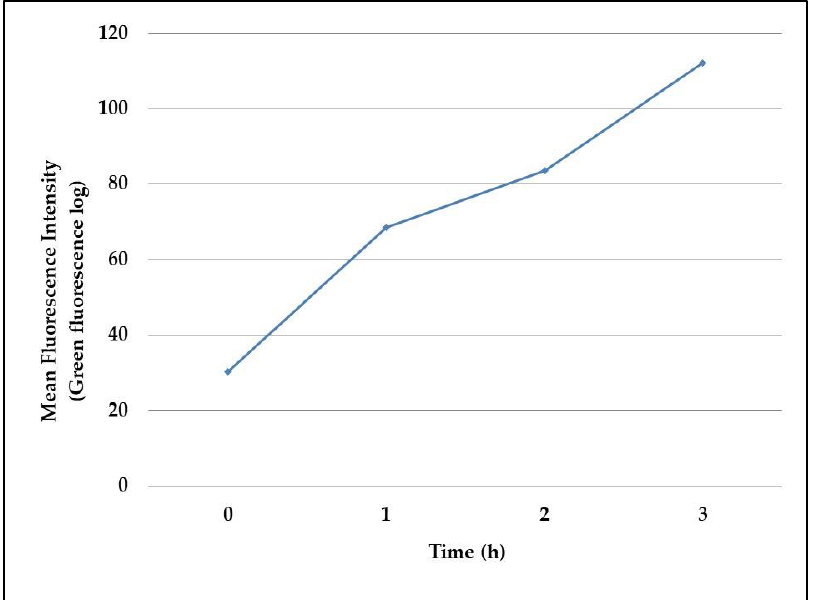
Figure 3. Green fluorescent protein production by P. aeruginosa PAEG1 detected by flow cytometry assays. The GFP(ASV) fluorescence was measured by flow cytometry in a culture of P. aeruginosa PAEG1 in LB broth containing 0.2% arabinose, incubated for 0, 1, 2 and 3 h at 37 °C. Every hour, a 200 µL aliquot of the culture was withdrawn, washed in phosphate buffered saline (PBS) and measured in the green channel. About 20,000 events/samples were considered, and the results are expressed as mean fluorescence intensity for each sample. Table 1. GFP-based flow cytometry (GFP-FC) viable counts of P. aeruginosa PAEG1 grown in broth or in biofilms. Sample Plate Count (CFU/mL) Broth culture (OD 600 =